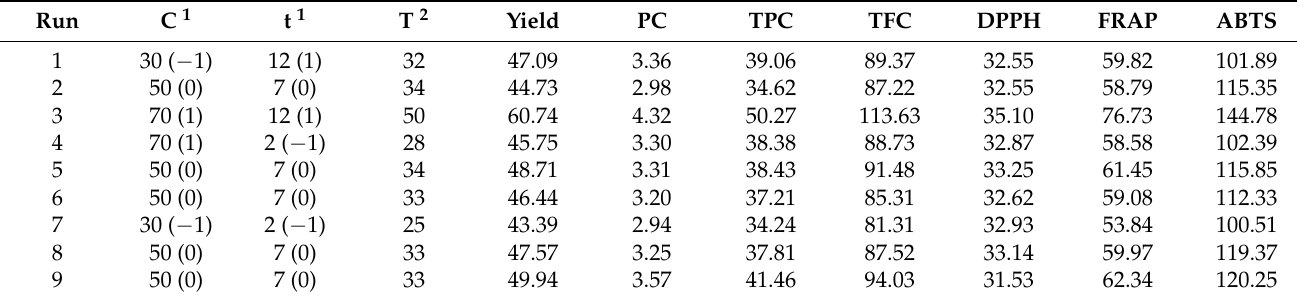
Table 6. Factorial experimental design in terms of actual and coded factors applied to the probe-type ultrasound-assisted extraction of exhausted olive pomace (EOP) and experimental values of the response variables: yield (%), phenolic concentration (PC) (g gallic acid equivalents/L), total phenolic content (TPC) (mg gallic acid equivalents/g EOP), total flavonoid content (TFC) (mg rutin equivalents/g EOP), and antioxidant activity (DPPH, FRAP, and ABTS) (mg Trolox equivalents/g